Question: Based on the figure, does the quantity rise or fall?
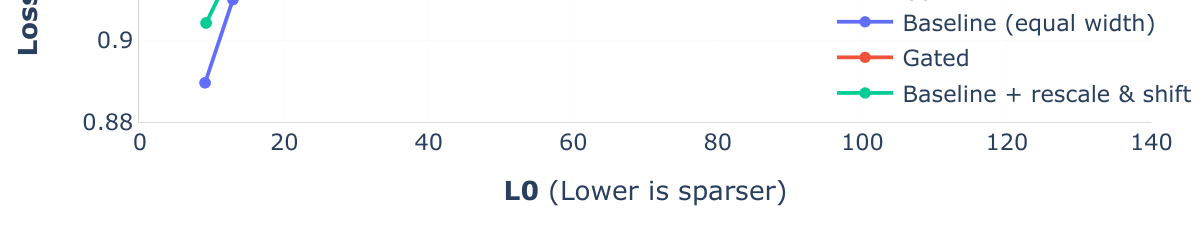
Answer: increasing